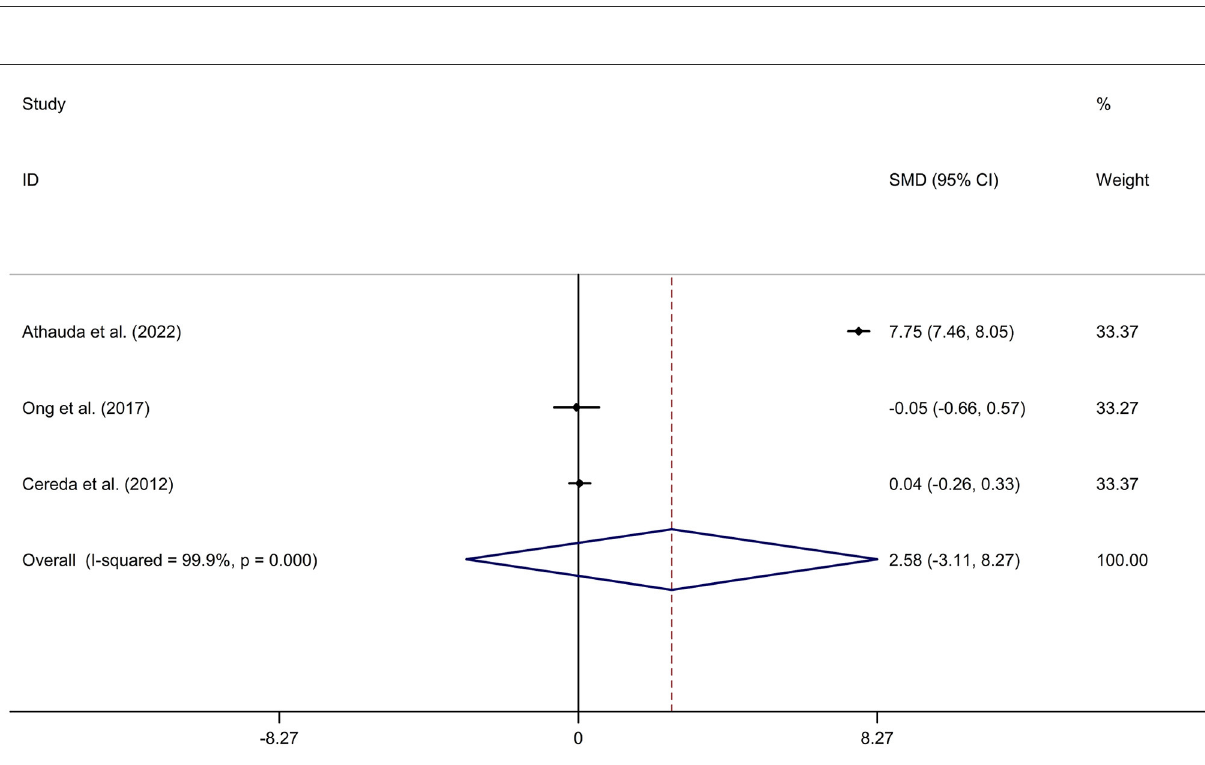
FIGURE4 Forest plot for comparison in change of motor function between PD-DM and PD-noDM. CI, confidence interval; DM, diabetes mellitus; PD, Parkinson’s disease; PD-DM, PD with DM; PD-noDM, PD without DM; SMD, standard mean